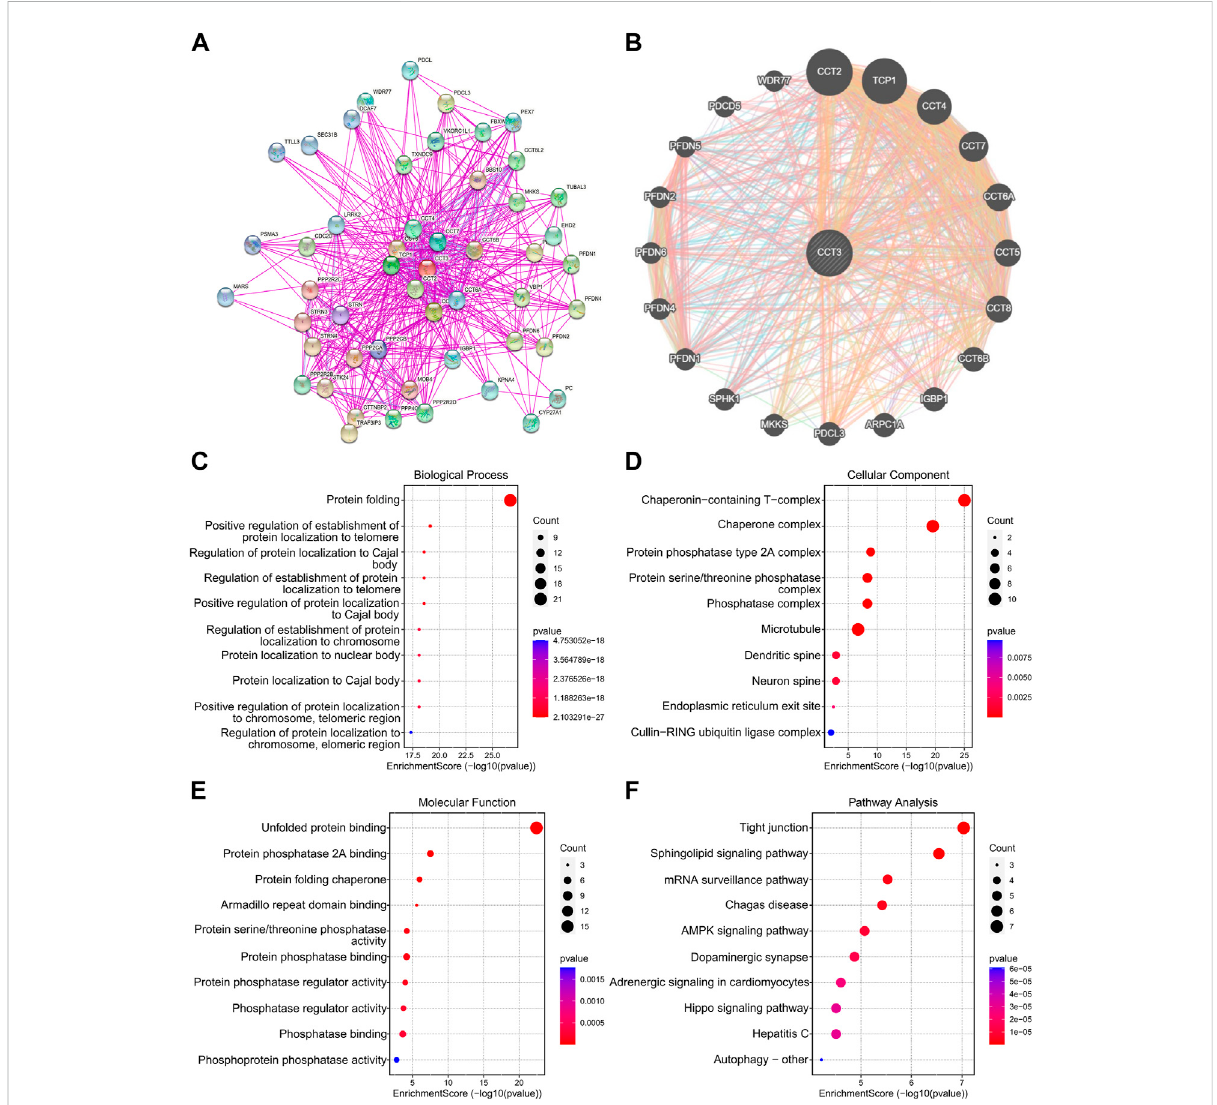
FunctionalenrichmentanalysisofCCT3. (A) Theprotein-proteininteraction(PPI)networksforCCT3wereobtained bytheSTRINGtool. (B) The top 20 CCT3-related genes were displayed using the GeneMANIA tool. (C – F) GO and KEGG analysis for CCT3-related genes. * p < 0.05, ** p < 0.01, *** p <